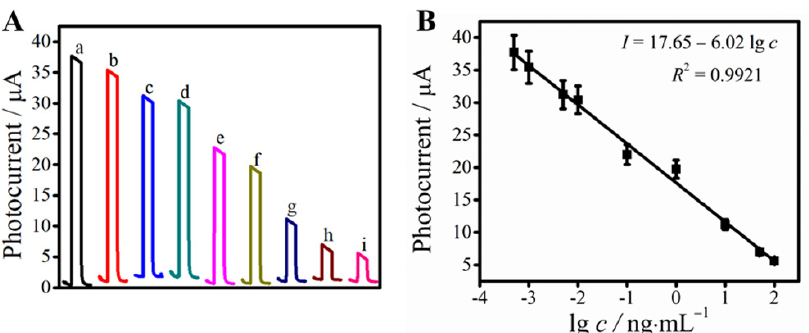
Figure 6. Photocurrent intensity of the immunosensor ( A ) and logarithmic calibration curve ( B ) of the PEC immunosensor at different PCT concentrations. The concentrations of PCT were 0.0005 (a), 0.001 (b), 0.005 (c), 0.01 (d), 0.1 (e), 1 (f), 10 (g), 50 (h), 100 (i) ng·mL − 1 ; Error bars = SD ( n = 5).